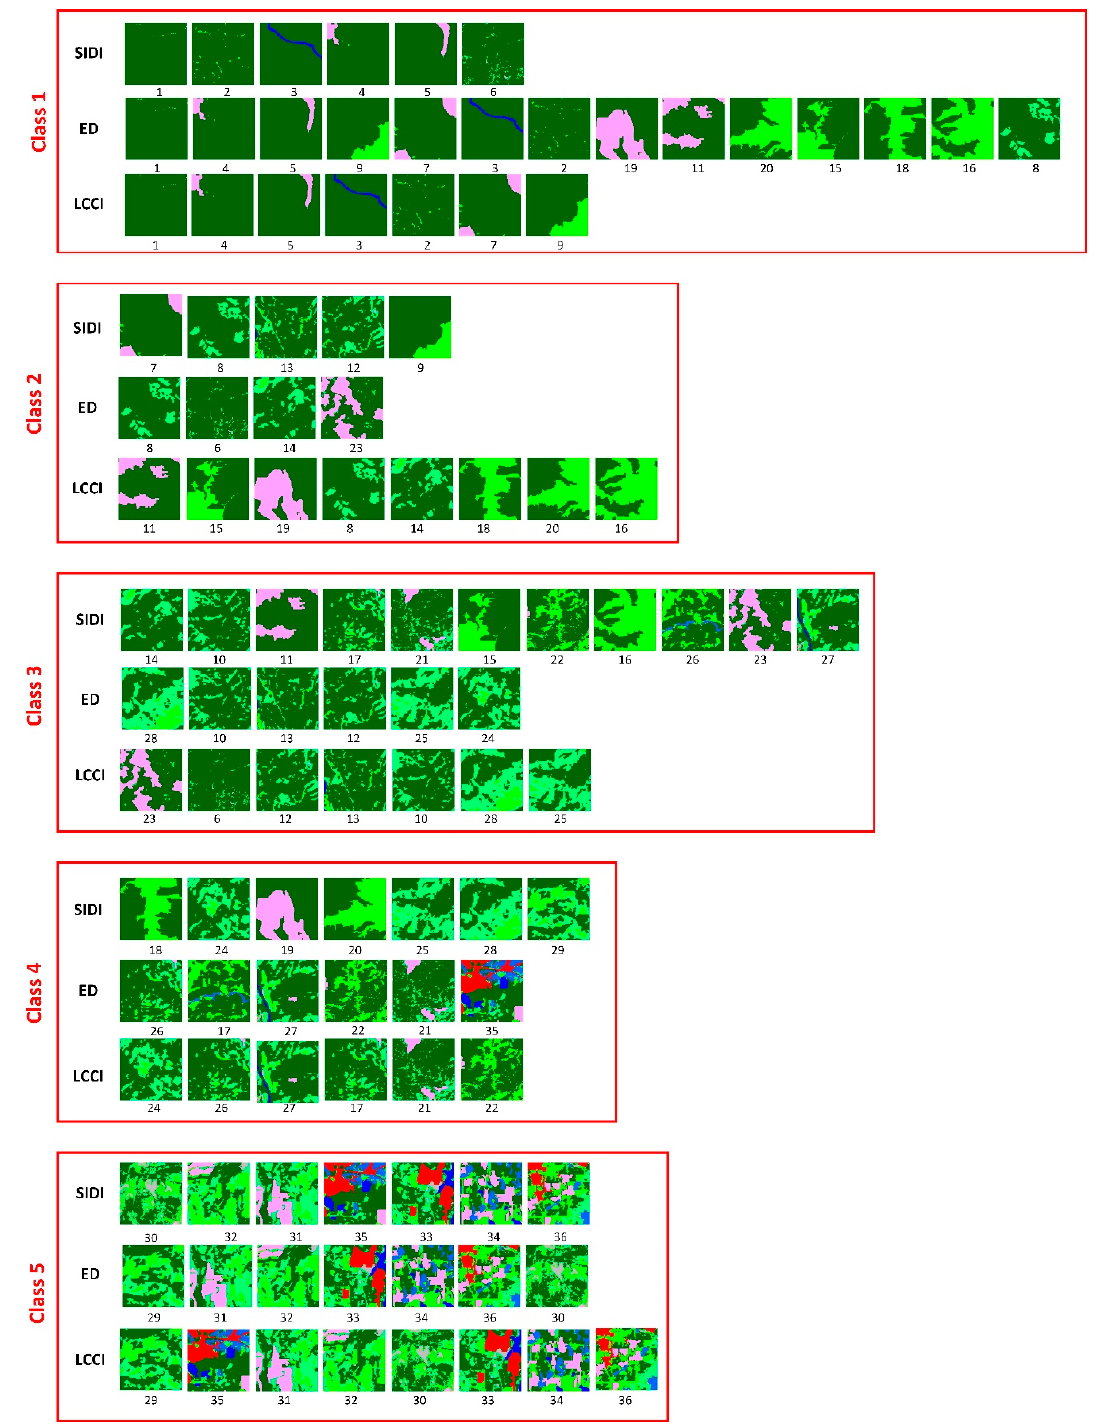
Figure 5. Evaluation dataset assigned to di ff erent land cover heterogeneity levels based on three metrics.